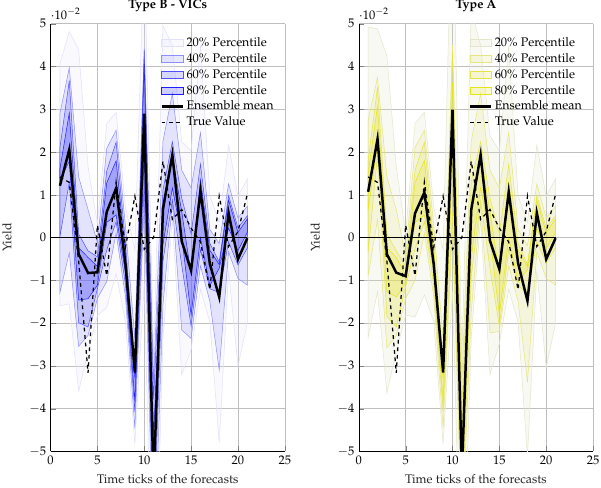
Figure 4. Comparison of the Forecast Results of the Ensembles from Network Type A (HCNN Baseline) and the Network Type B (Extended Network with the Data of the VICs).